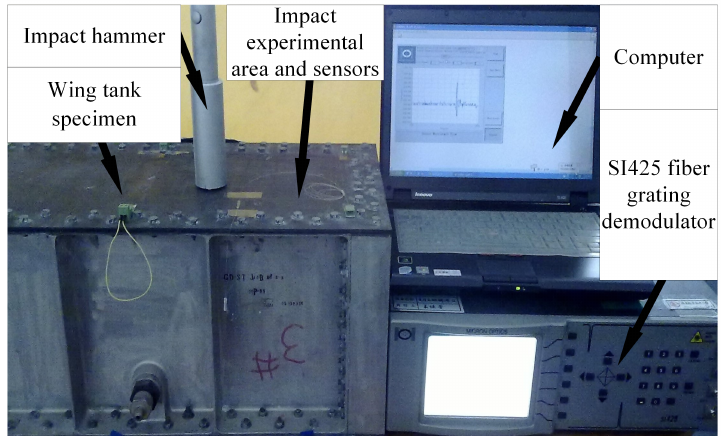
Figure 7. Impact monitoring system of a wing tank based on FBG